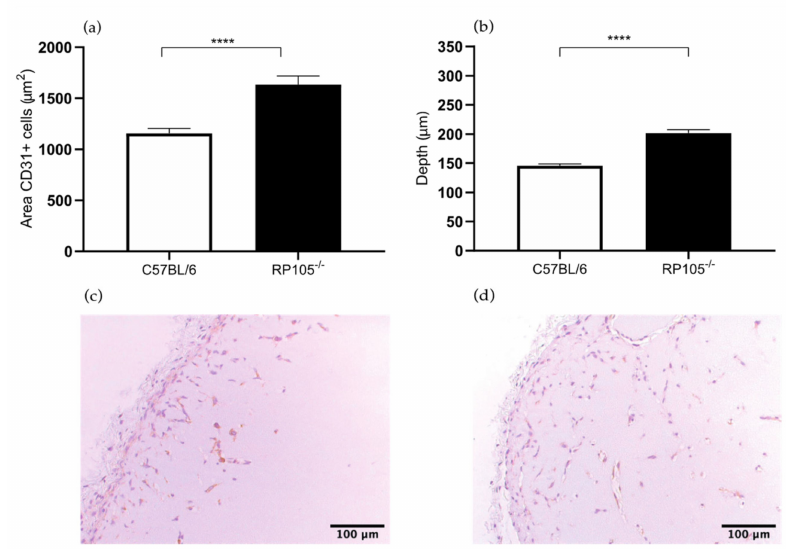
Figure 3. ( a ) Area of CD31 + cells in the subcutaneously injected Matrigel, in RadioProtective 105 (RP105) − / − and wild type C57BL/6 mice. ( b ) Quantification of the depth ( µ m) of ingrowth of CD31 + cells into subcutaneously injected Matrigel, in RP105 − / − and wild type C57BL/6 mice. ( c ) Im- munohistochemical staining of paraffin-embedded Matrigel plug of C57BL/6 7 days after Matrigel injection, using anti-CD31 antibodies. ( d ) Immunohistochemical staining of paraffin-embedded Matrigel plug of RP105 − / − mice 7 days after Matrigel injection, using anti-CD31 antibodies. N = 6 mice per group, 2 Matrigel plugs per mouse. Values are presented as the mean SEM. **** p ≤